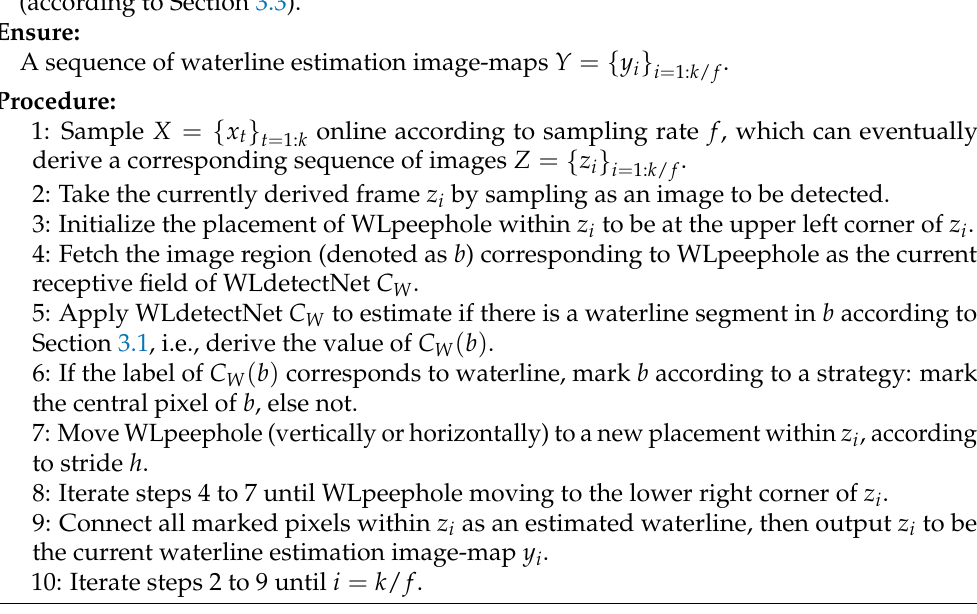
Algorithm 1 : Waterline Detection